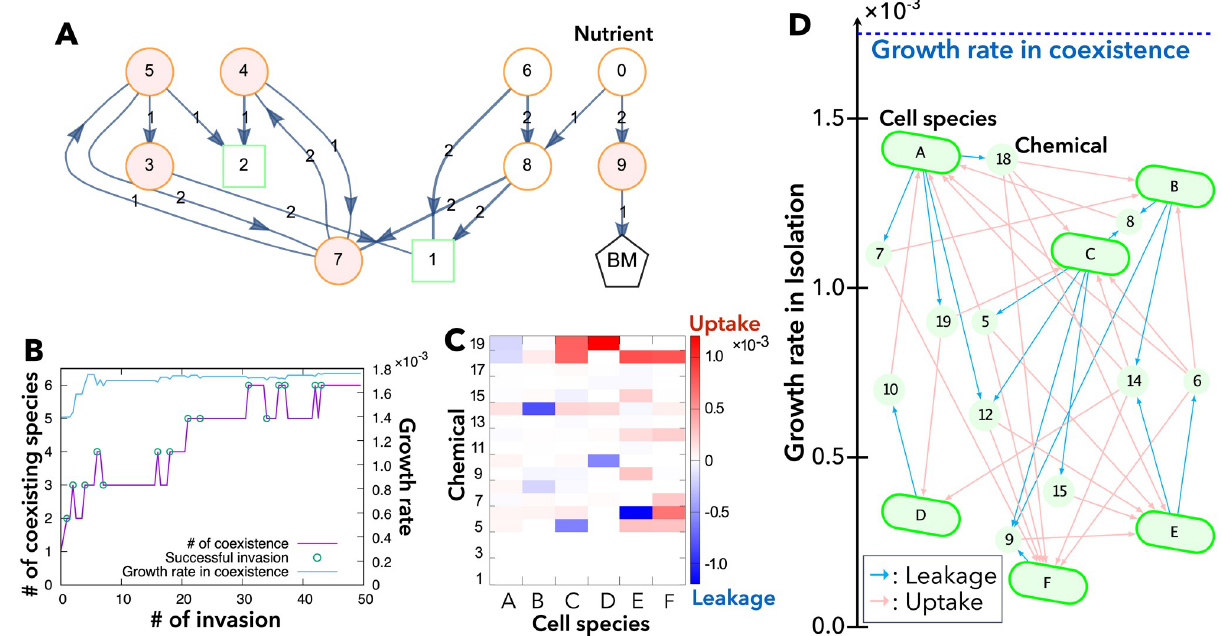
Fig 3. Example of symbiosis with metabolic exchange via the environment. (A) An example of randomly generated networks with n = 10. The enzyme labeled on each arrow catalyzes the conversion of the metabolite at the arrowtail to the metabolite or enzyme at the arrowhead. Among n chemicals, chemicals 1 and n enzyme = 2 are enzymes (green squares) and the nutrient chemical 0 and chemicals n enzyme + 1 = 3 to n − 1 = 9 are metabolites (orange circles). The leak-advantage metabolites in isolation conditions (chemicals 3–5, 7, and 9) are highlighted by pink. See also S3(B) Fig for the network of cell species B in panels (C) and (D). (B) Time series of the number of coexisting species through successful invasions by new species and the growth rate of coexisting cell species. (C) Plot of leakage (blue) and uptake (red) fluxes of non-nutrient chemicals from each cell species A-F. (D) Structure of metabolic exchange among six cell species that have different growth rates in isolation. The vertical axis represents the growth rate of each cell species α in isolation, m ð a Þ . Cyan and pink arrows indicate the leakage and uptake of each chemical component, respectively. Symbiosis among multiple species increases the iso . In the numerical simulations in growth rate to μ symbiosis (as indicated on the top), which is higher than the growth rate of each cell species in isolation, m ð a Þ iso ¼ 0 : 03 ; V ¼ 3 : 0 ; D ð env Þ (B)-(D), the parameters were set to n ¼ 20 ; r ¼ 2 ; S env env